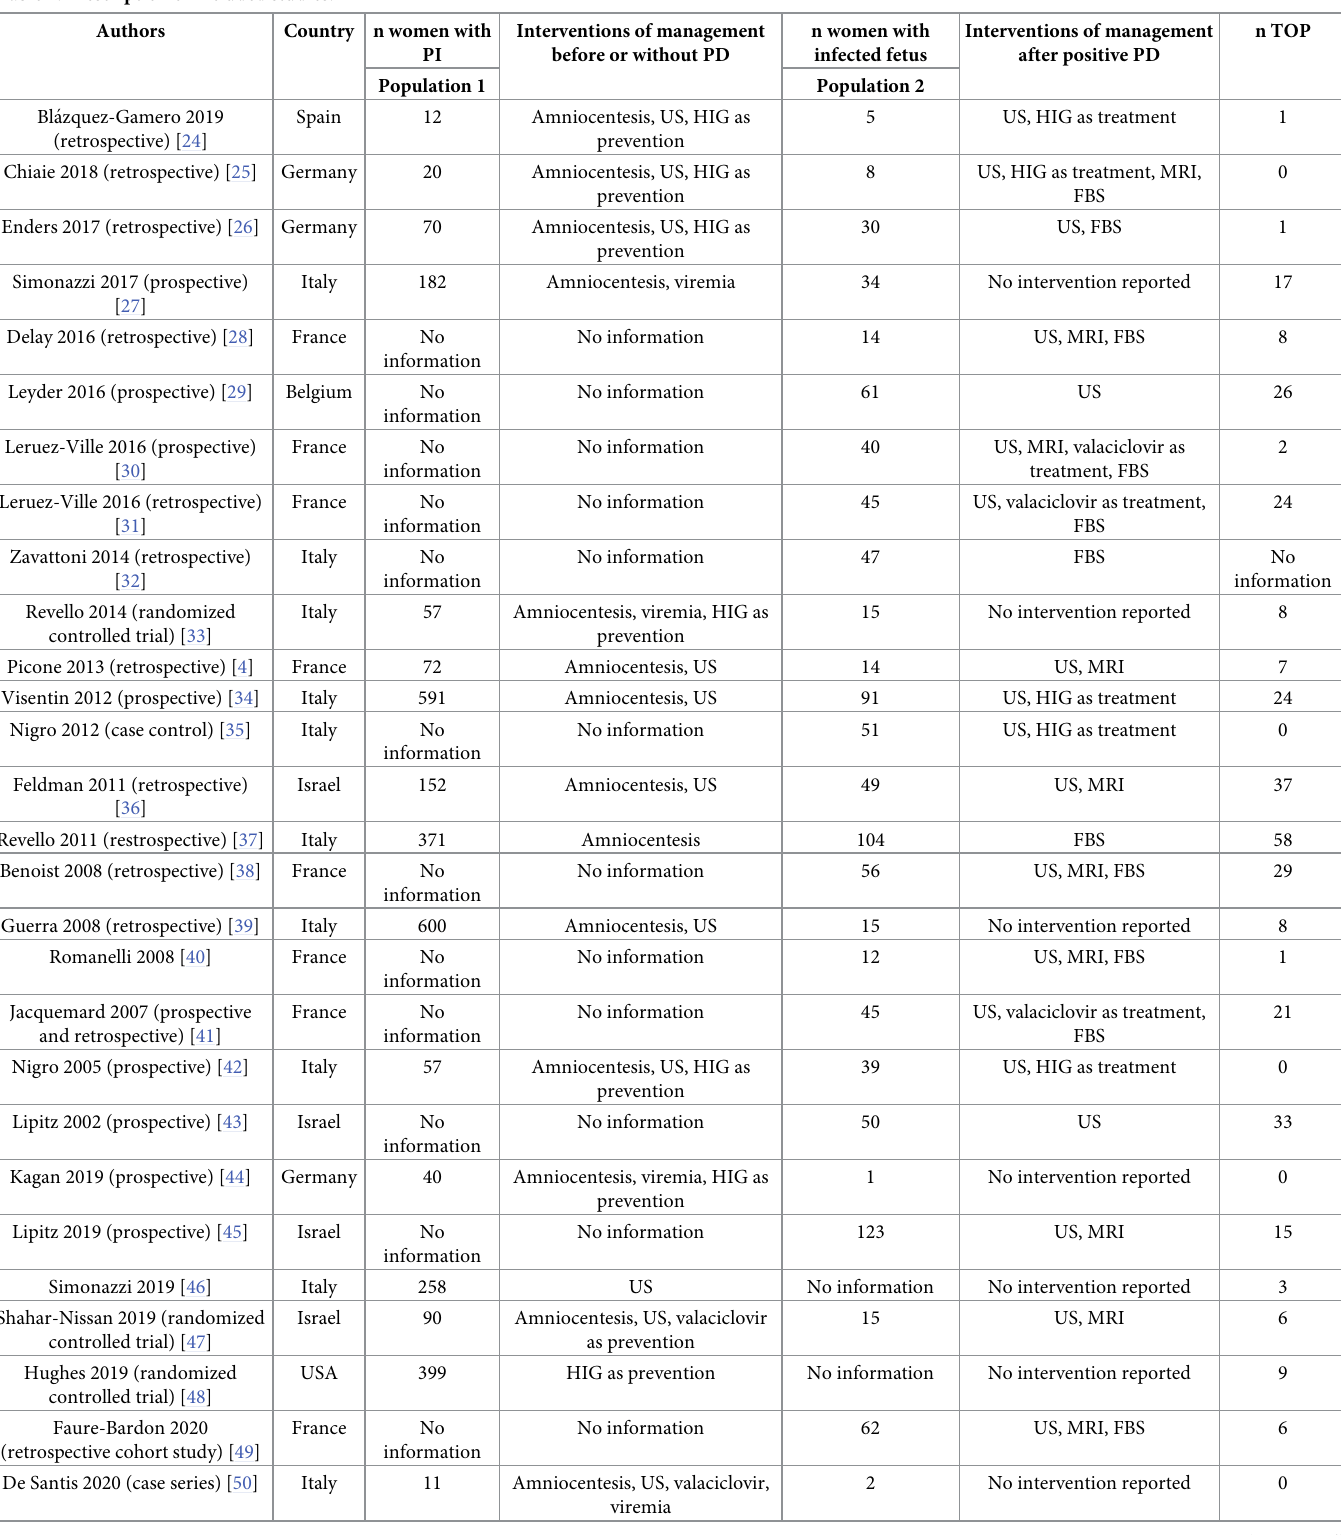
Table 1. Description of included